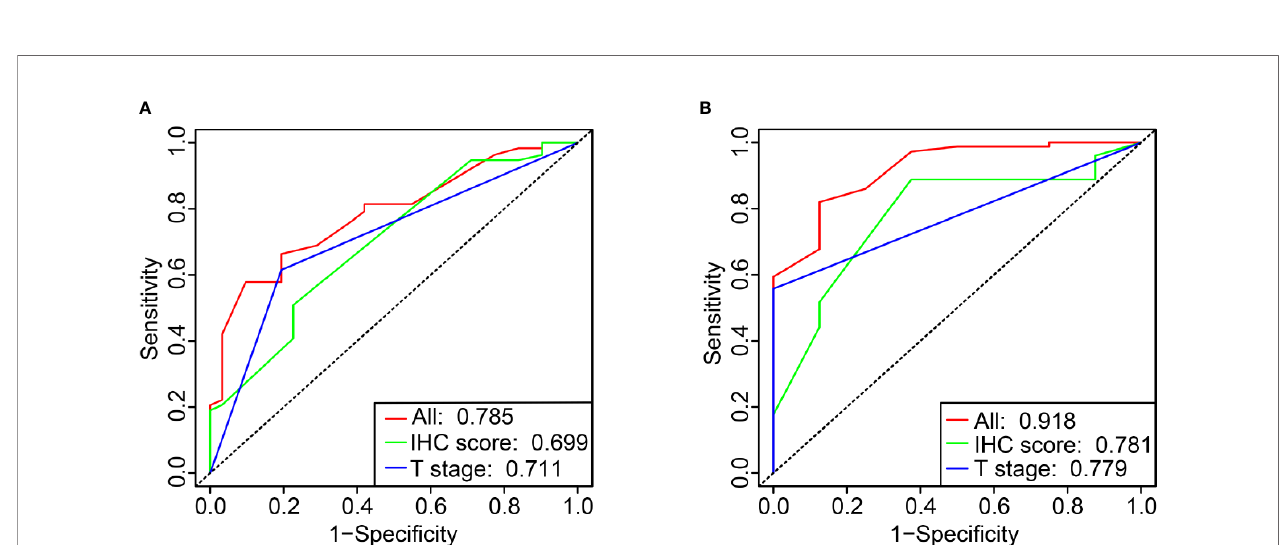
FIGURE 5 | Time-dependent ROC curve comparing the prognostic value of IHC score in 5 and 10 years with that of T stage (A, B)